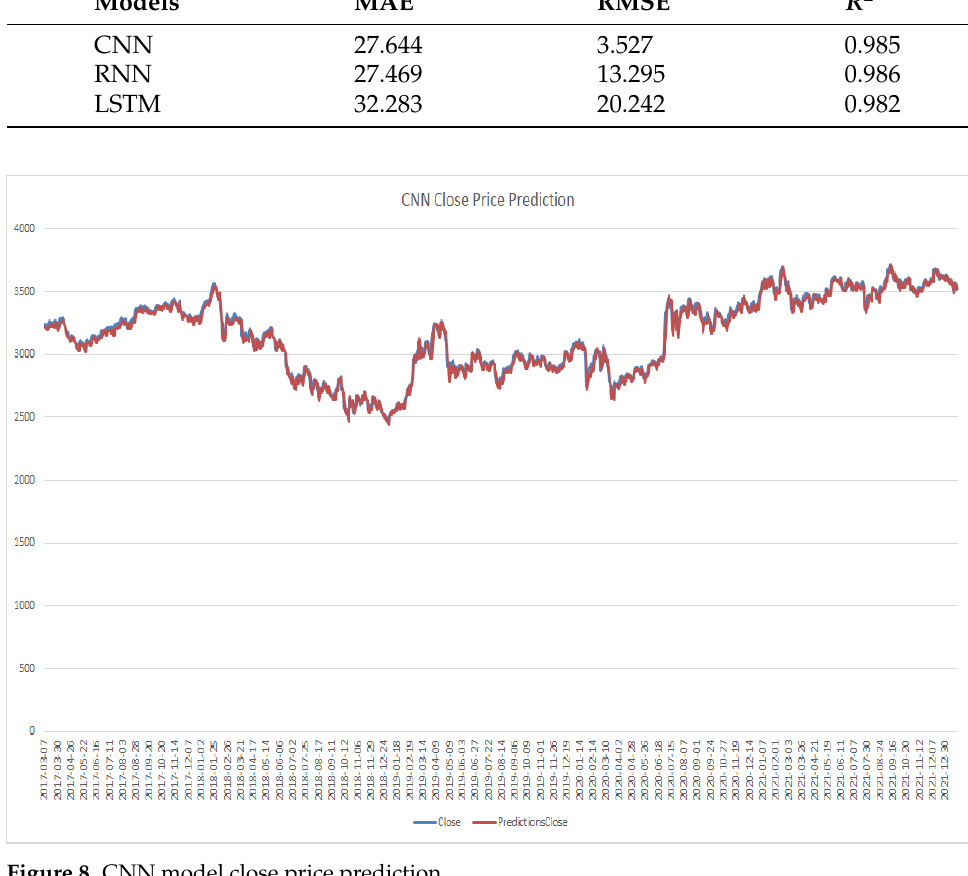
Figure 8. CNN model close price prediction.